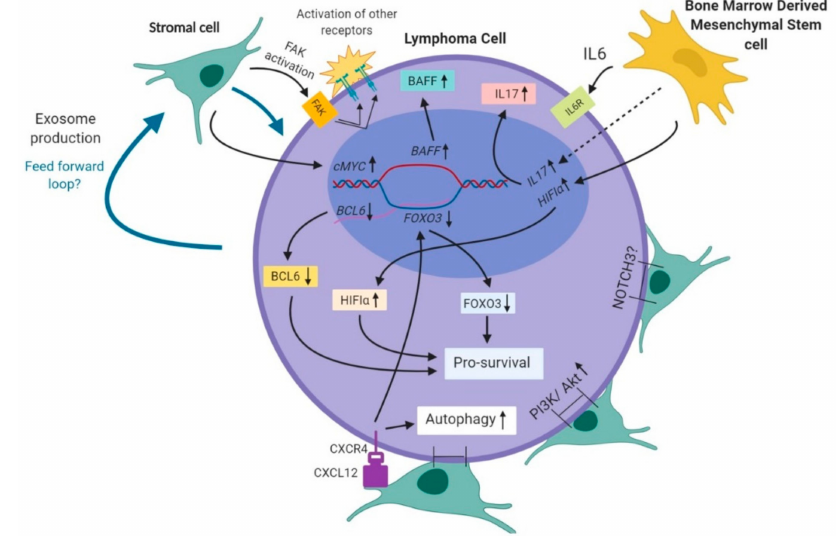
Figure 1. Suggested pathways for the promotion of tumor survival with the aid of the bone marrow microenvironment. Blue compartment: Nucleus, Purple compartment: Cytoplasm, Cells in green: stromal cells, Cells in yellow: BM derived mesenchymal stem cell. Text in black within the nucleus indicates the transcriptional change of respective components / genes. The subsequent e ff ect on respective protein production is indicated through arrows outside the nucleus in the cytoplasm (names of proteins in